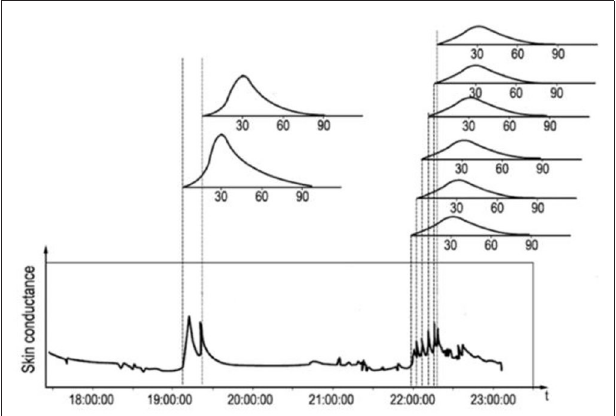
FIGURE 3 | Skin conductance trace of a female with its characteristic response peaks and the hypothesized associated delayed salivary cortisol response curves above the graph.